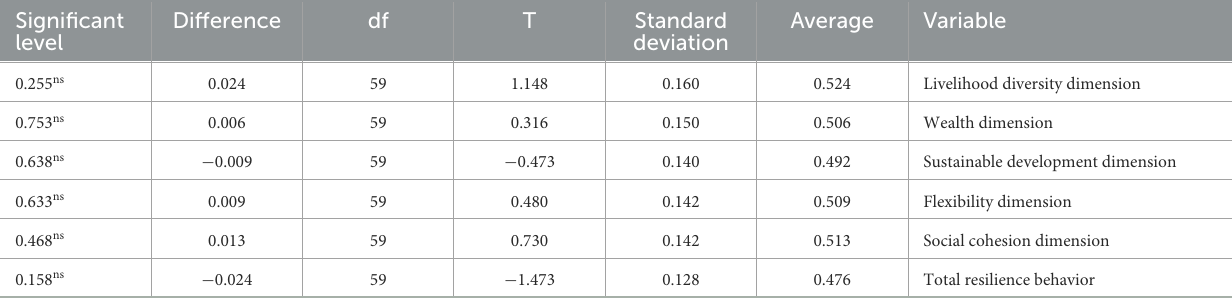
TABLE 8 Comparison of the resilience of pistachio farmers in rural areas of Rafsanjan and Anar against moderate climate changes. Significant level